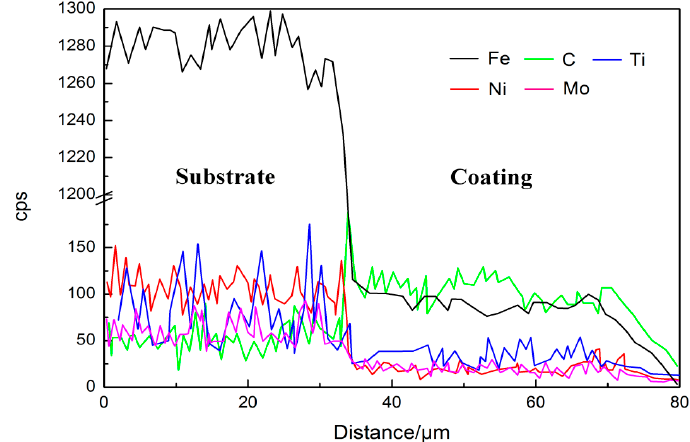
Figure 6. Energy dispersive X-ray spectroscopy (EDS) linear scanning profiles of the main elements across the cermet coating.